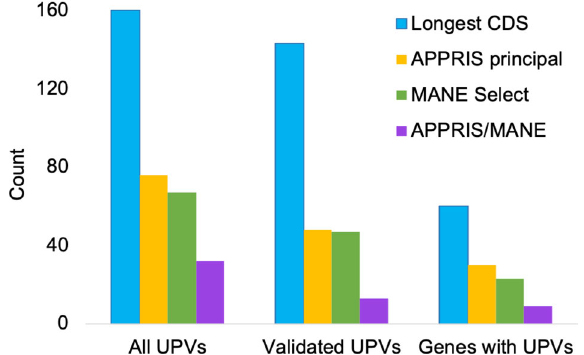
Fig. 6 Pathogenic variants not captured by reference transcripts. ClinVar Pathogenic, Likely pathogenic and Pathogenic/Likely patho- genic variants with PubMed support that are not captured by reference transcripts are here termed uncaptured pathogenic variants (UPVs). The method for reference transcript selection is shown in the legend. “ All UPVs ” are all pathogenic variants with PubMed citations that are not captured by the reference transcripts, “ Validated UPVs ” are those uncaptured pathogenic variants with PubMed support that were validated by manual curation, “ Genes with UPVs ” are the number of distinct genes with validated uncaptured pathogenic variants.